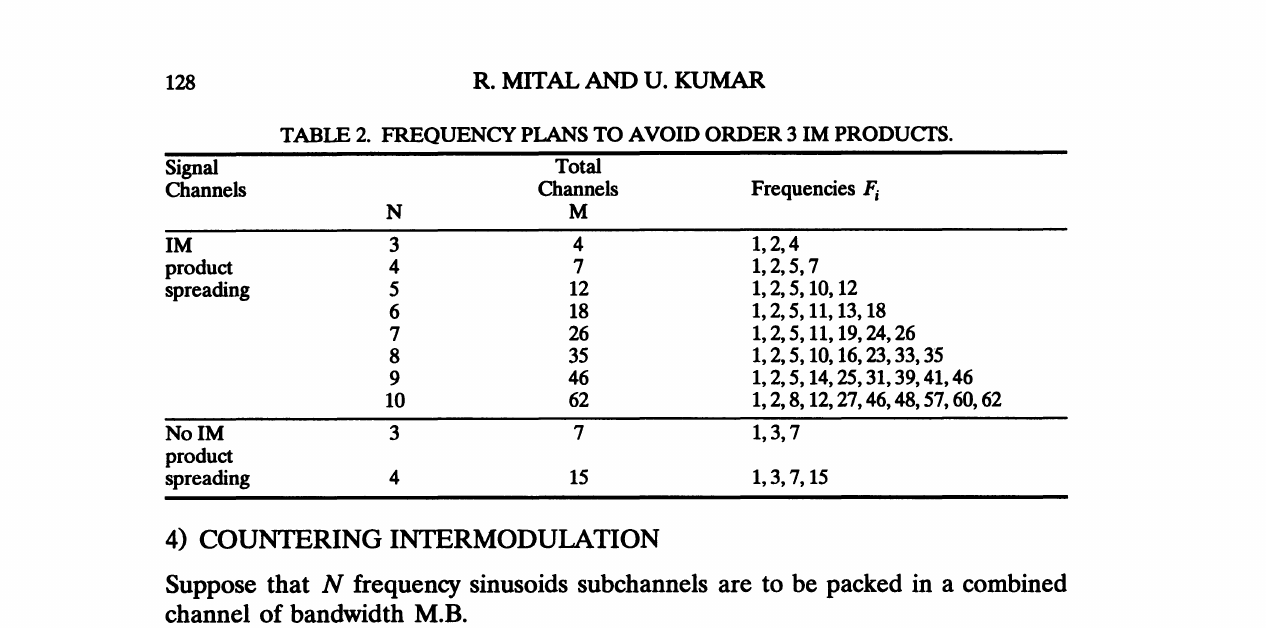
TABLE 2. FREQUENCY PLANS TO AVOID ORDER 3 IM